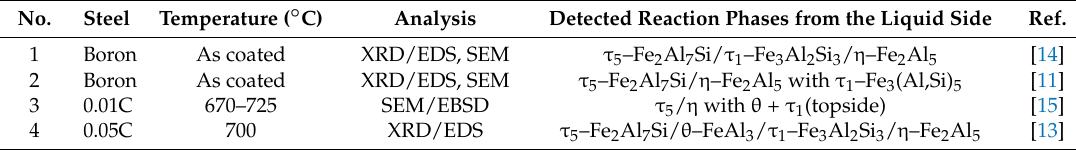
Table 3. Configuration of the phases in the reaction layer as found in the recent